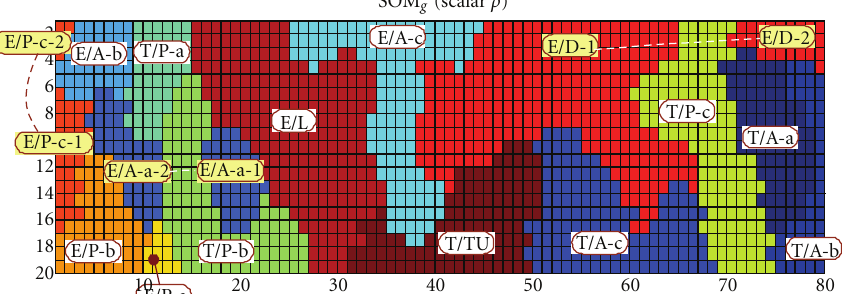
Figure 12: Clusters on the new SOM g map (case of scalar ρ ).